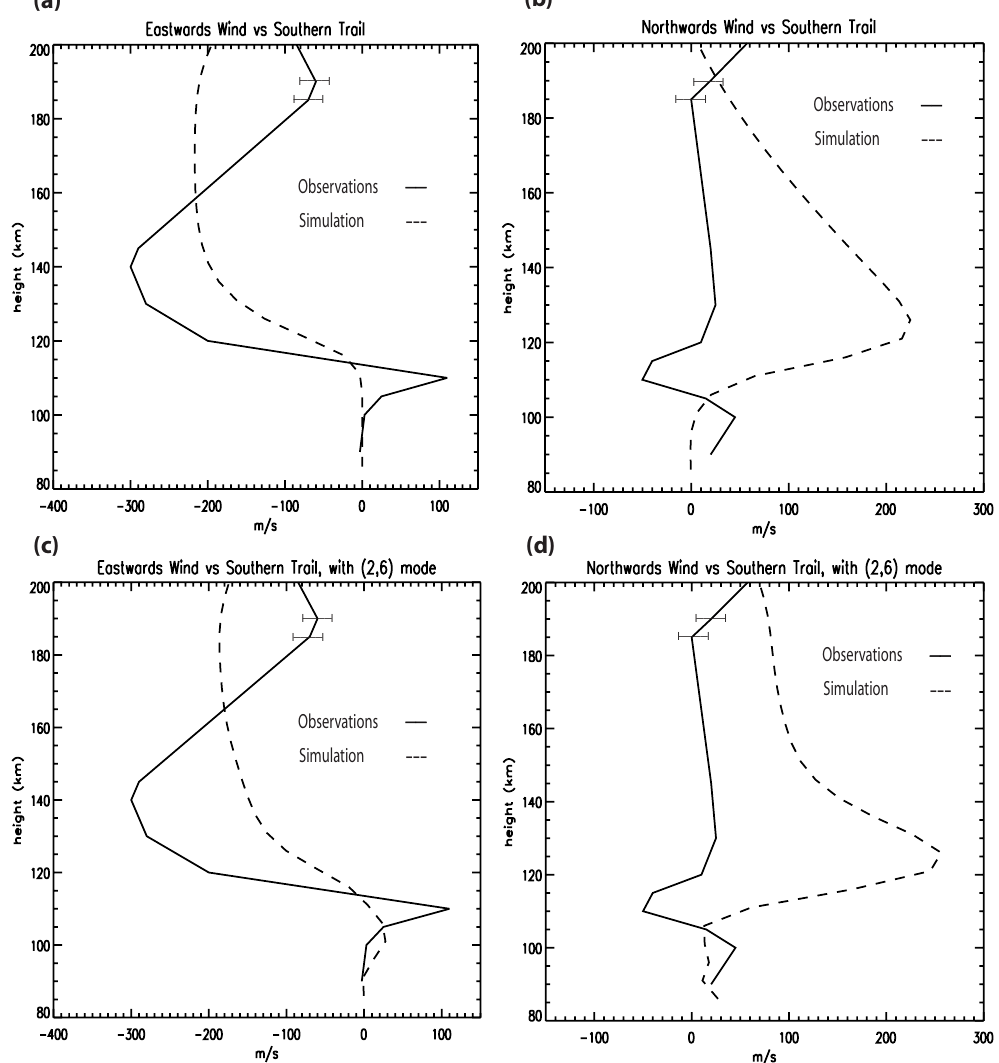
Fig. 4. Wind profiles simulated using ion densities and electric fields based on the 28 February dusk side campaign measurements. Results are compared with the southern trail winds observed during the same campaign. (a) and (b) response with no background winds (c) and (d) response with background winds including the (2,6) mode, amplitude 300m, phase